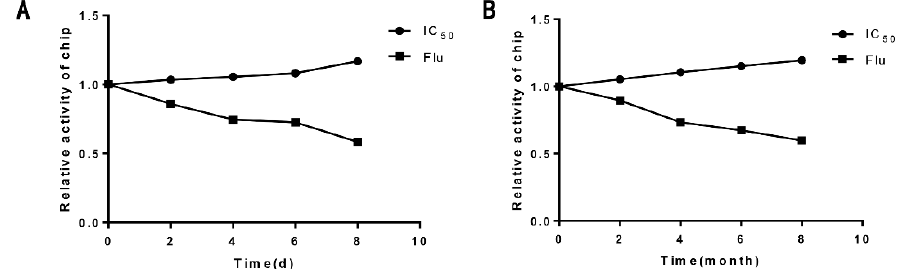
Figure 8. Stability of cephalosporins antibody chip biosensor at 37 °C ( A ) and 4 °C ( B